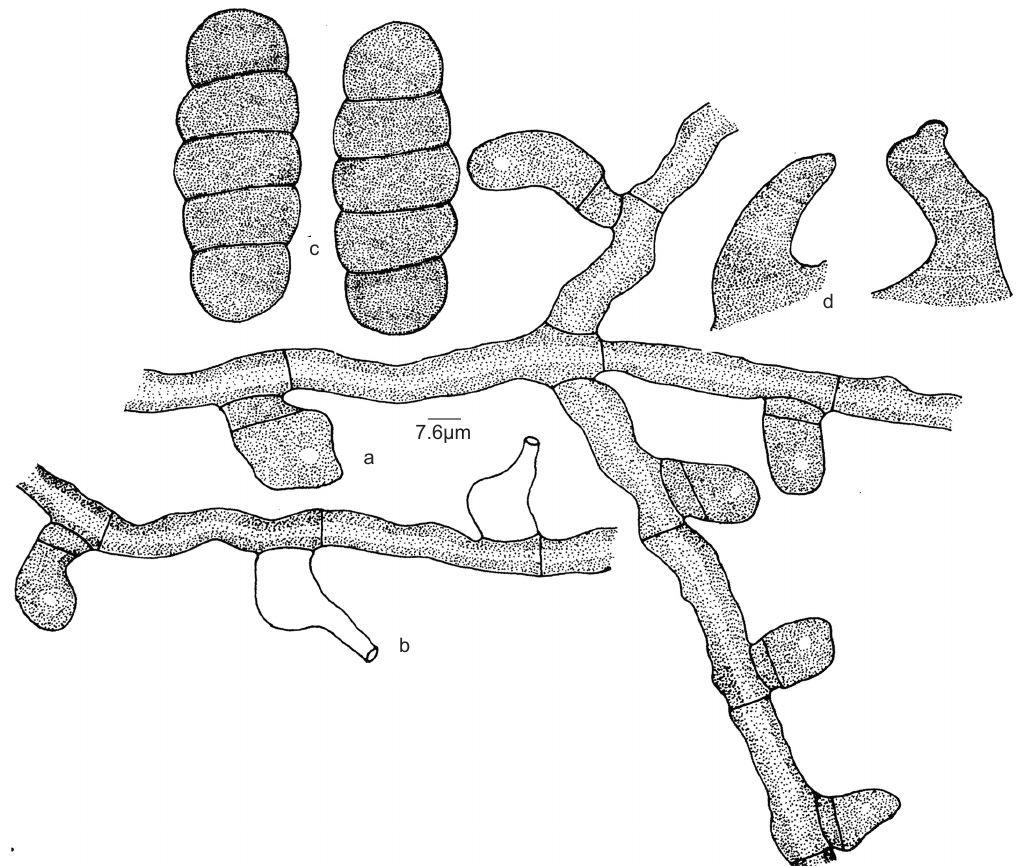
Figure 1. Appendiculella elaeocarpicola sp. nov. a - Appressorium; b - Phialide; c - Ascospores; d - Perithecial appendage